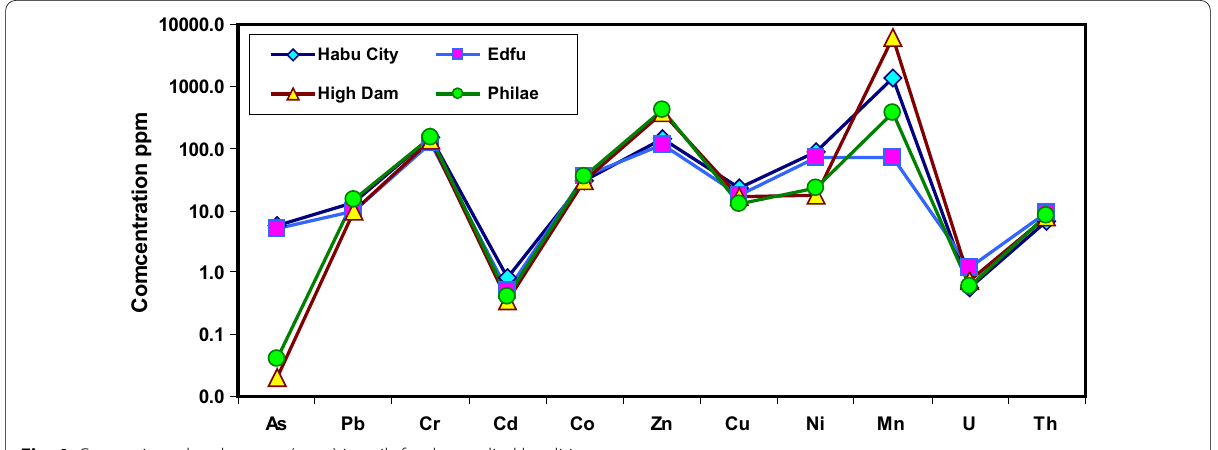
Fig. 4 Comparison the elements (ppm) in soils for the studied